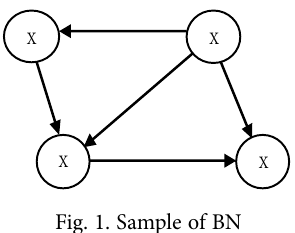
Fig. 1. Sample of